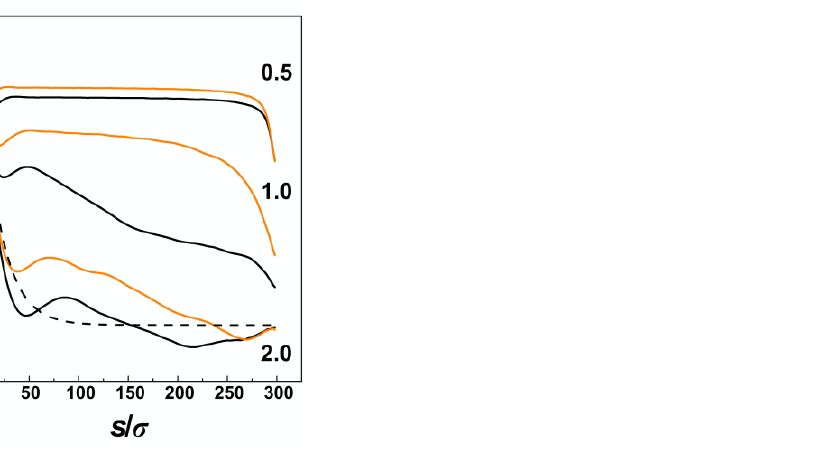
Figure 4. The orientational correlation functions along the coarse-grained curvature s / σ of the DNA polymer as obtained from simulations of DNA confined in nano-channels without external compressive force. The values obtained for cylindrical and helical channels are distinguished by black and orange colours and the strength of confinement in terms of the ratio D/P is indicated by number 0.5, 1.0 and 2.0. The the dashed line corresponds to the decay of orientational correlations of unperturbed DNA in the bulk <cos θ > = exp ( − s / P ) [61].